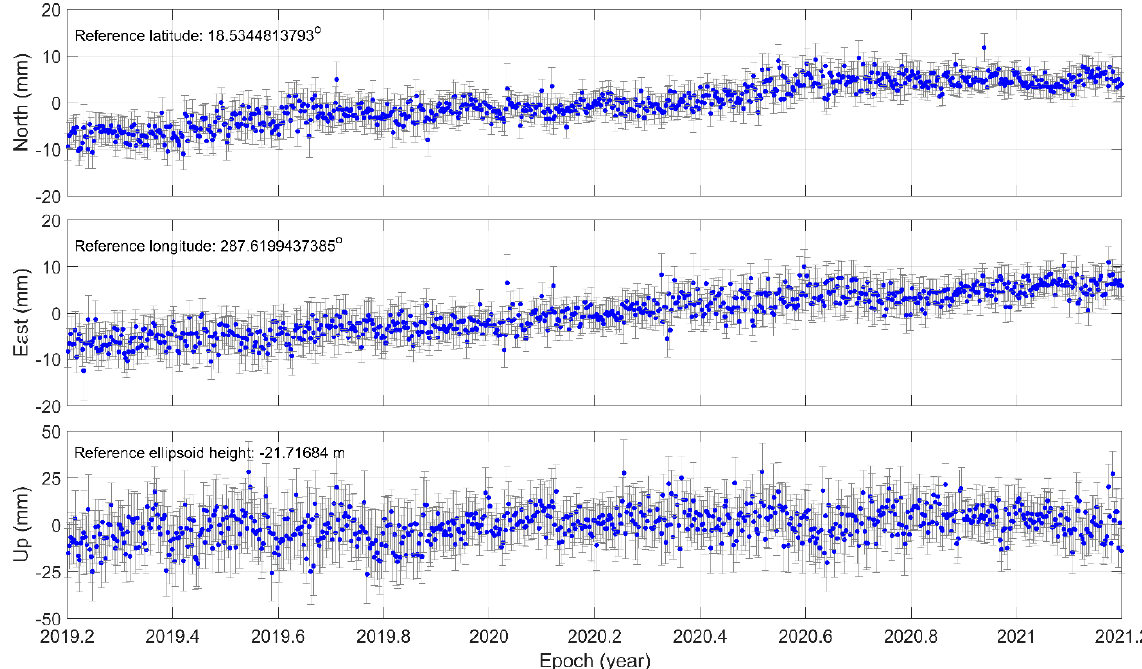
Figure 8. Position time series at Port-au-Prince GNSS station.